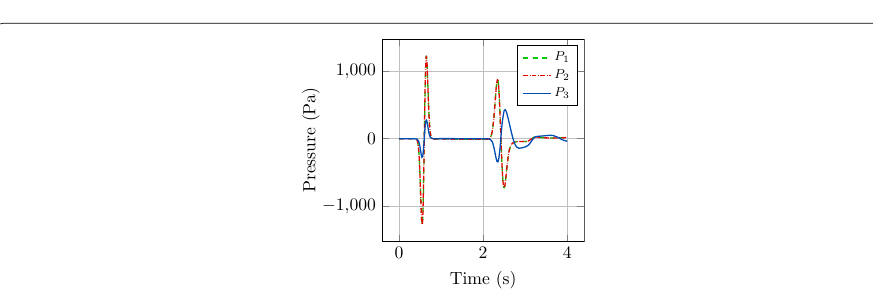
Fig. 8 Time evolution of the pressure field in a homogeneous isotropic medium in three locations (see Fig. 7 for locations)